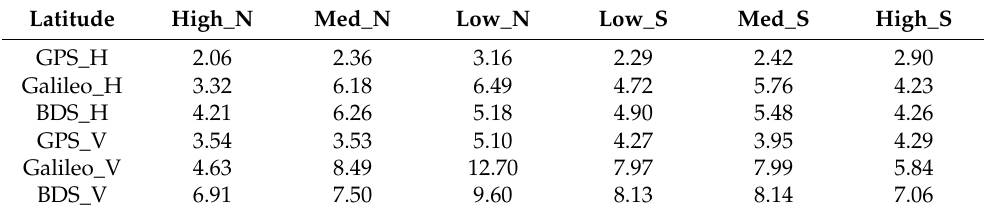
Table 5. The mean RMS (unit: cm) of the different latitudes for kinematic PPP. Latitude High_N Med_N Low_N Low_S Med_S High_S